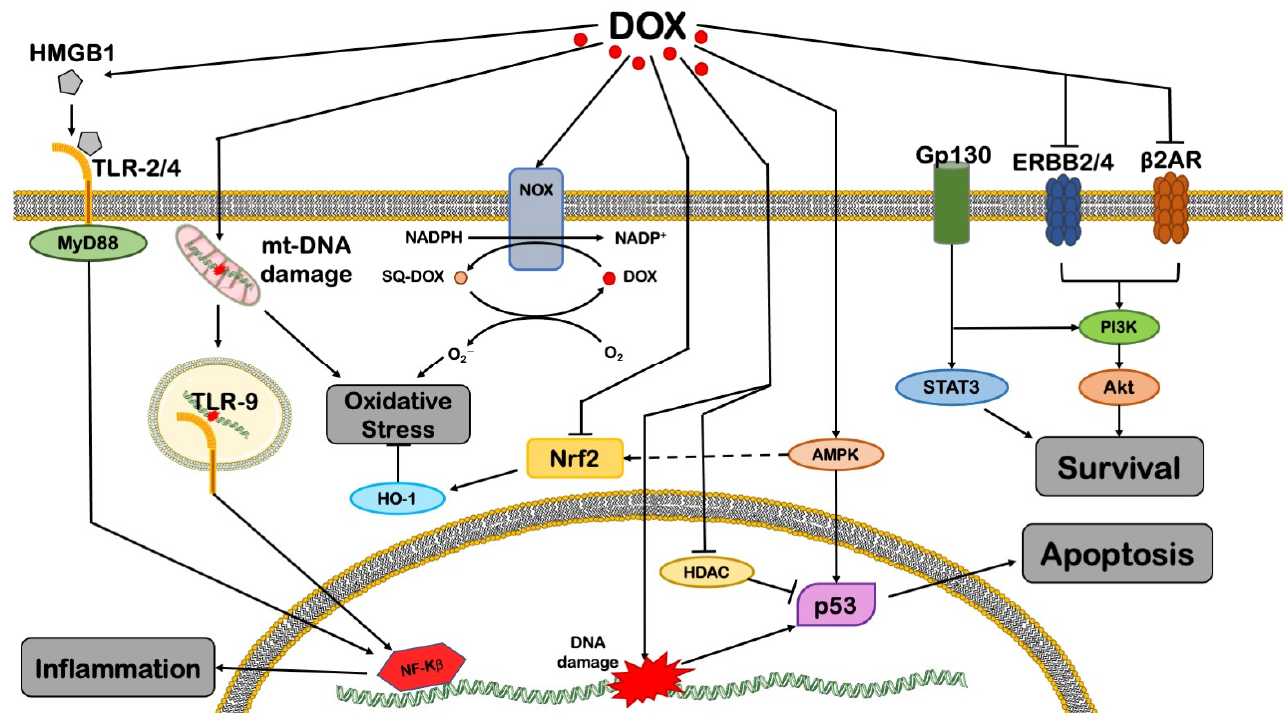
Figure 1. An overview of DOX-induced cytotoxicity in cardiomyocytes. The image reports the main mechanisms mediating the harmful effects of DOX. See text for further details. AMPK = AMP- activated protein kinase; AR = adrenergic receptor; Gp130 = glycoprotein 130; HDAC = histone deacetylase; HMGB1 = high-mobility group box 1; HO-1 = heme oxygenase 1; mtDNA = mitochondrial DNA; MyD88 = myeloid differentiation primary response 88; NADP = nicotinamide adenine dinucleotide phosphate; NF-kB = nuclear factor kappa-light-chain-enhancer of activated B cells; NOX = NADPH oxidase; NRF2 = nuclear respiratory factor 2; PI3K γ = phosphoinositide 3- kinase γ ; sq-DOX = doxorubicin (semiquinone form); STAT3 = signal transducer and activator of transcription 3; TLR = Toll-like receptor. This illustration includes elements from Servier Medical Art.